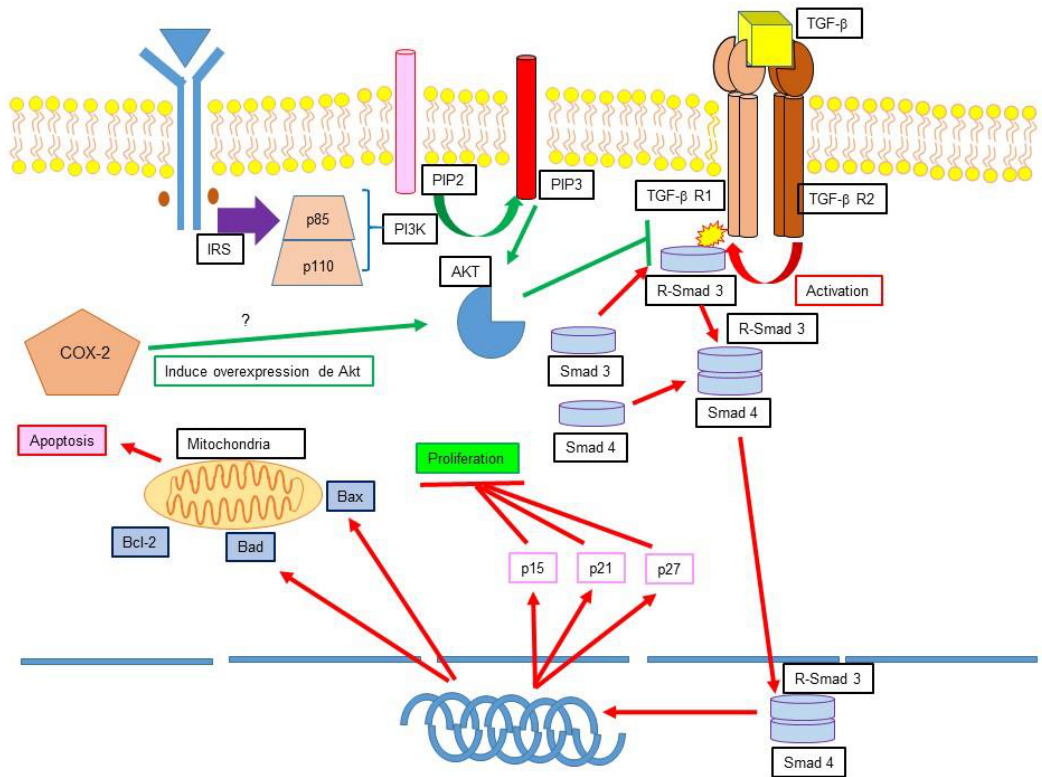
Figure 4. Apoptosis inhibition in cancer. Schematic representation compiling some of the described mechanisms of apoptosis inhibition in cancer cells. Certain cancer cells have been observed to activate the PI3K-Akt pathway as survival mechanisms. In healthy cells and early-stage cancer cells, Transforming growth factor β (TGF- β ) can induce cell-cycle arrest and apoptosis. However, there is evidence proving that in late-stage cancer cells, TGF- β can promote tumorigenesis, metastasis, and chemoresistance. Another described mechanism for cancer cell survival is the activation of the Ciclooxygenase 2 (COX-2) pathway, which activated Akt and inhibits the overall antitumor effect of TGF- β in healthy cells or early-stage cancer cells.